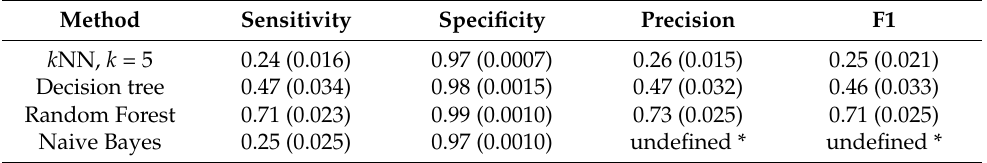
Table 2. The averaged metrics obtained on the feature vector level for the four classification methods. The standard deviation is provided in